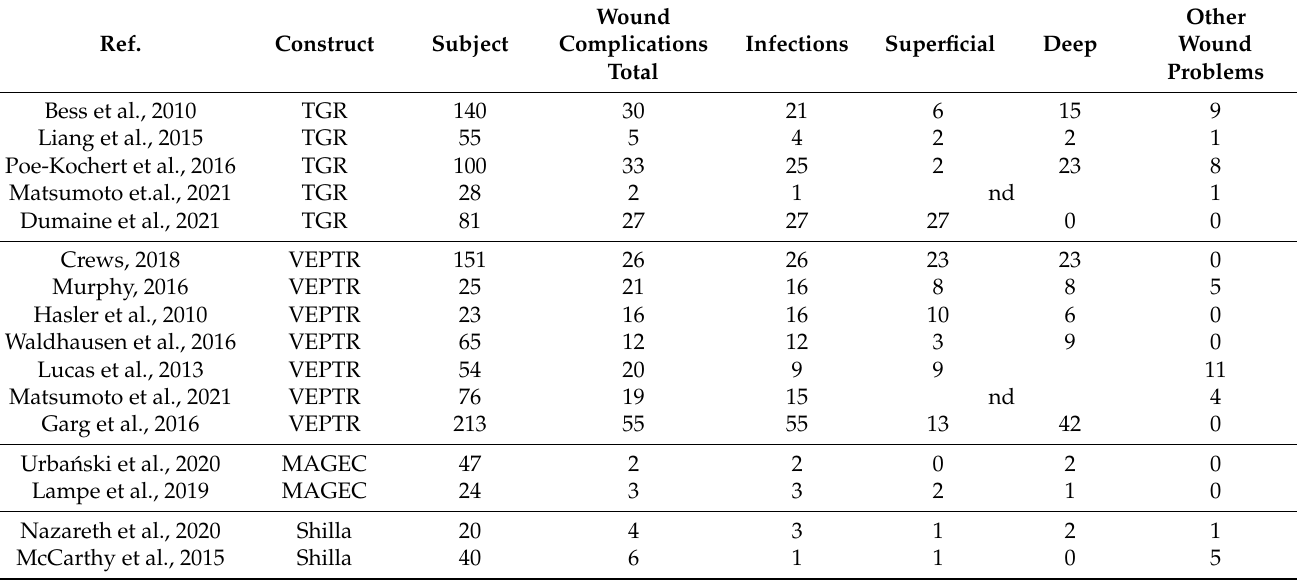
Table 4. Number of wound complications stratified into superficial, deep, and other wound